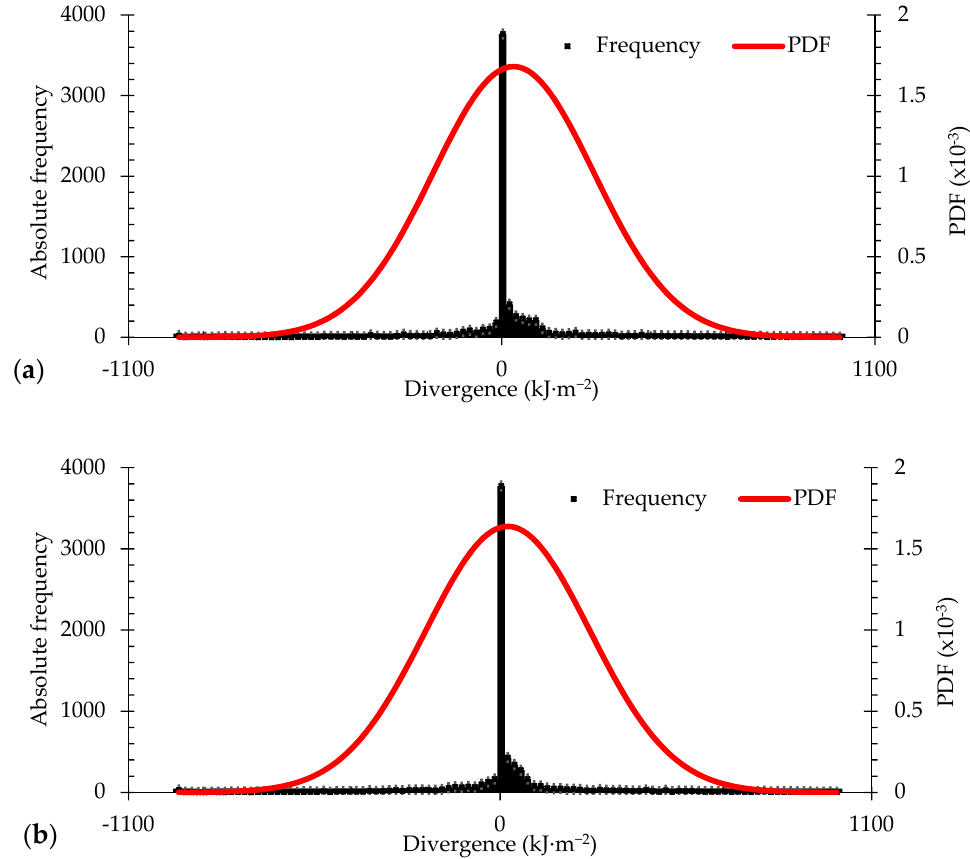
Figure 16. Relative frequency of the divergences for the prototypes: ( a ) P01, ( b ) P02. According to Figure 16a, the frequency distribution characteristics for prototype P01 had a mean ( µ ) of 37.16 kJ · m − 2 and a standard deviation ( δ ) of 276.92 kJ · m − 2 . The results provided by system P01 had a confidence level of 90.53% of the divergences located in the range of ( − 500 kJ · m − 2 ; 500 kJ · m − 2 ). On the other hand, the frequency distribution for prototype P02 (Figure 16b) presented a mean ( µ ) value equal to 21.29 kJ · m − 2 and a standard